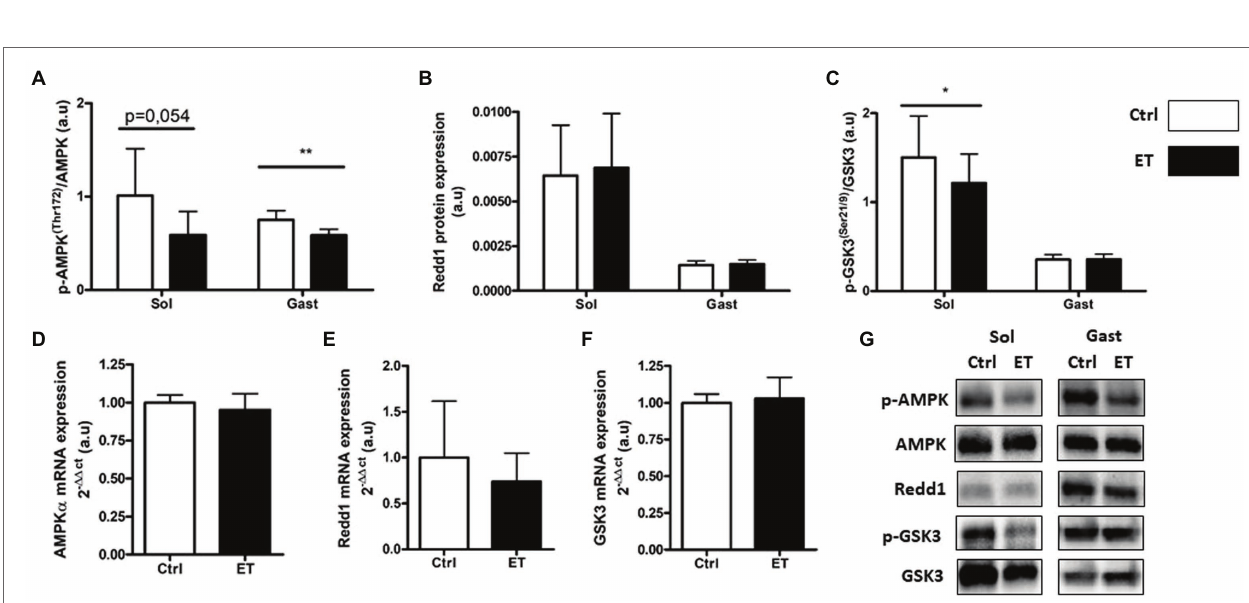
FIGURE 6 | Ergothioneine effect on autophagy markers 2 h after exercise. Autophagy markers in soleus and gastrocnemius muscle and expression of genes encoding autophagy markers in gastrocnemius muscle. (A) Phosphorylated ULK1 (Ser757)/total ULK1 ratio. (B) LC3.2/LC3.1 protein ratio. (C) p62 protein expression. (D) Atg7 mRNA level. (E) Pink1 mRNA level. (F) Parkin mRNA level. (G) Representative Western Blots; ** p < 0.01 vs. Ctrl.